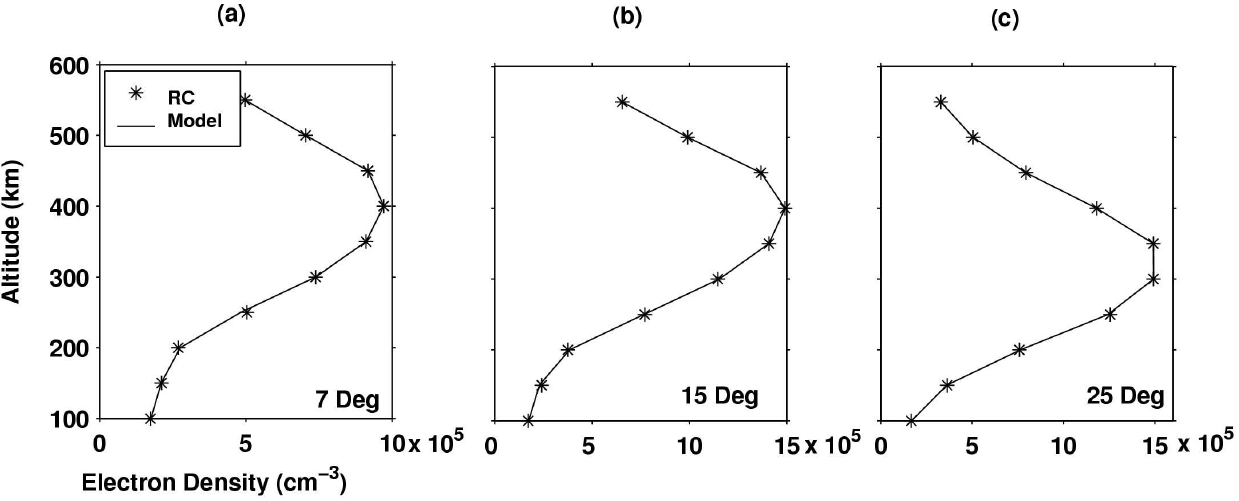
Fig. 4. Three typical vertical profiles. The continuous curve represents the model electron density profiles and the points are the result of the tomographic inversion.